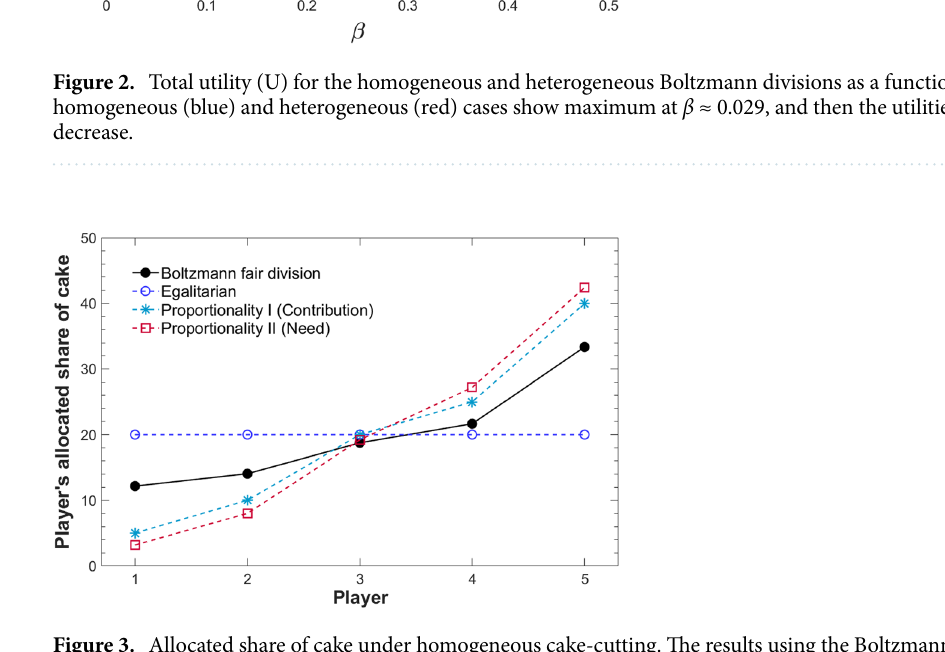
Figure 3. Allocated share of cake under homogeneous cake-cutting. The results using the Boltzmann division are compared with three conventional division criteria, Egalitarian (uniform cake division), Proportionality I (contribution), and Proportionality II (need). Note that the Boltzmann fair division shows a well-balanced division between Egalitarian and Proportionality I and